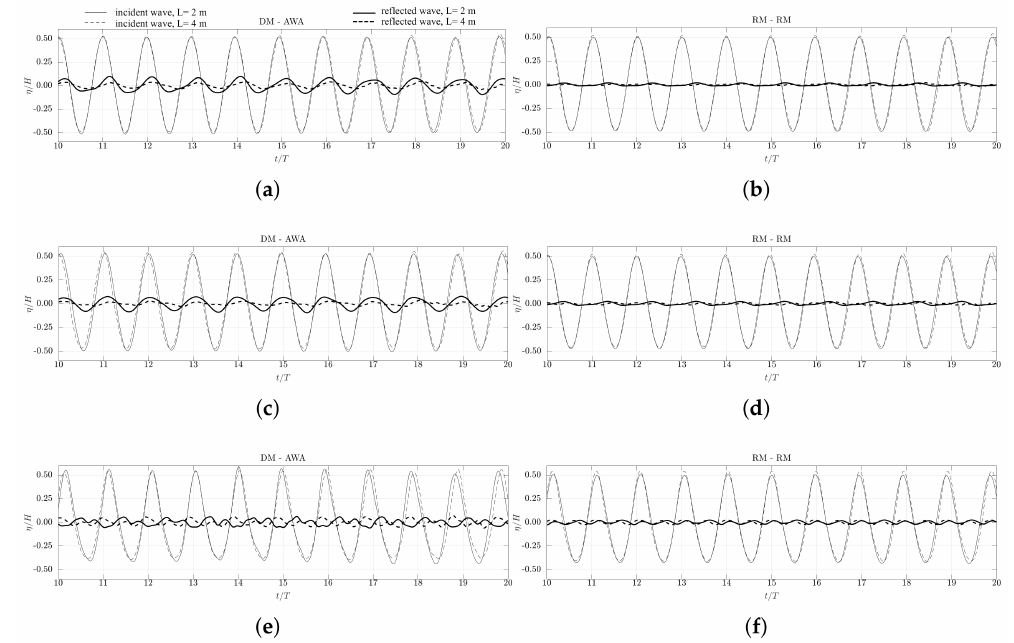
Figure 2. Normalized incident (regular line) and reflected (bold line) components for the different combinations of the methods. The solid line represents the waves with L = 2 m, and the dashed line is for the waves with L = 4 m. ( a ) Cases a and b from Table 1 ( H = 0.02 m), using DM-AWA; ( b ) Cases a and b from Table 1 ( H = 0.02 m), using RM-RM; ( c ) Cases c and d from Table 1 ( H = 0.04 m), using DM-AWA; ( d ) Cases c and d from Table 1 ( H = 0.04 m), using RM-RM; ( e ) Cases e and f from Table 1 ( H = 0.1 m), using DM-AWA; ( f ) Cases e and f from Table 1 ( H = 0.1 m), using